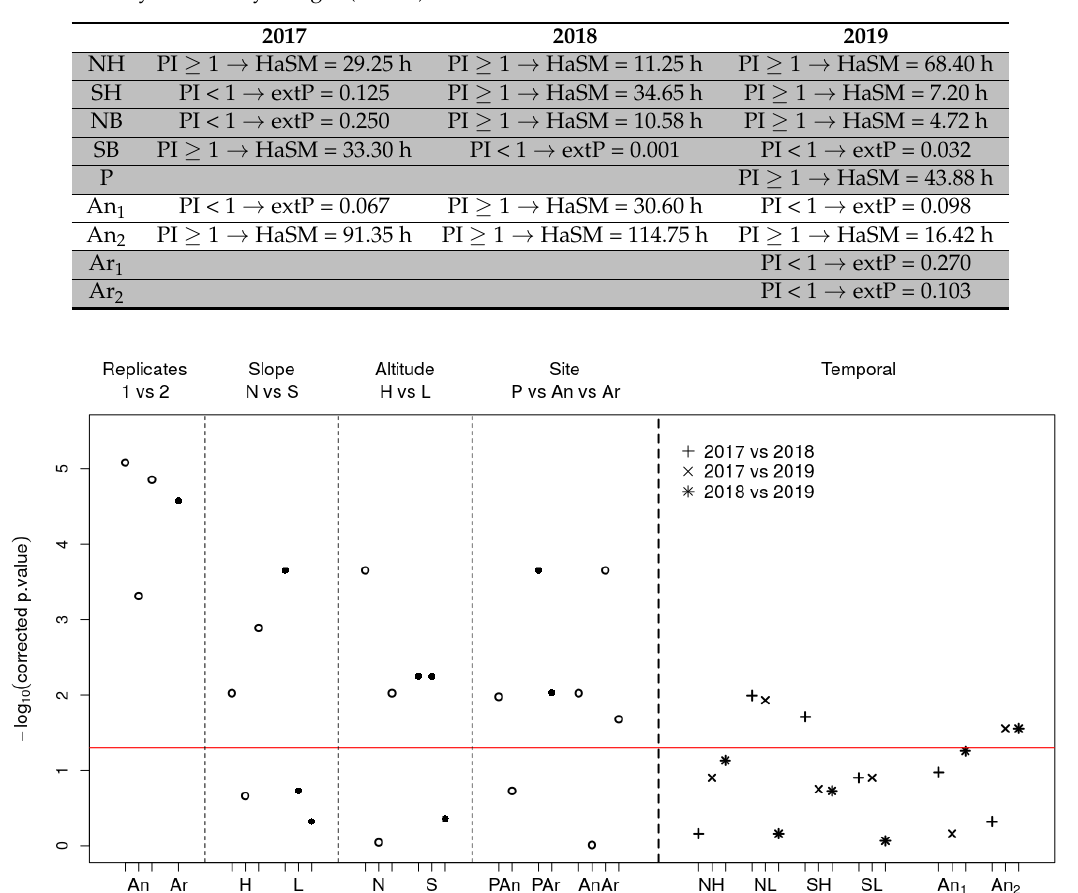
Table 2. Interpretation of the persistence index, calculation of the extinction probability (extP), and of the activity time safety margin (HaSM).